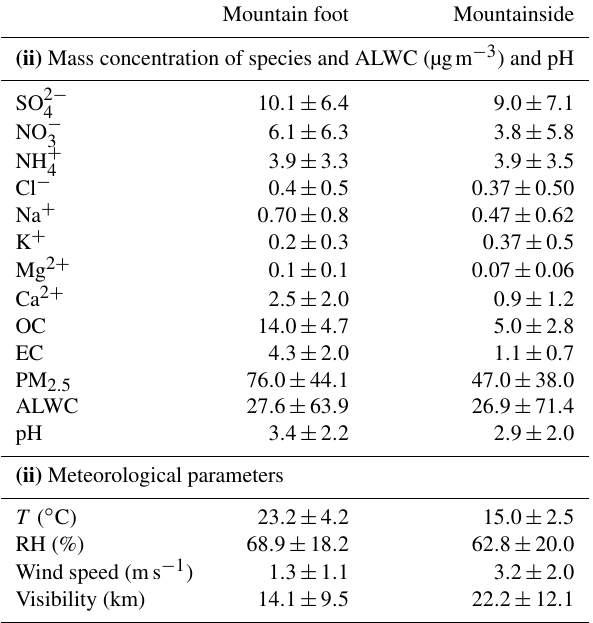
Table 1. Mass concentrations of species in the PM 2 . 5 samples, pH, and the meteorological conditions at the two sampling